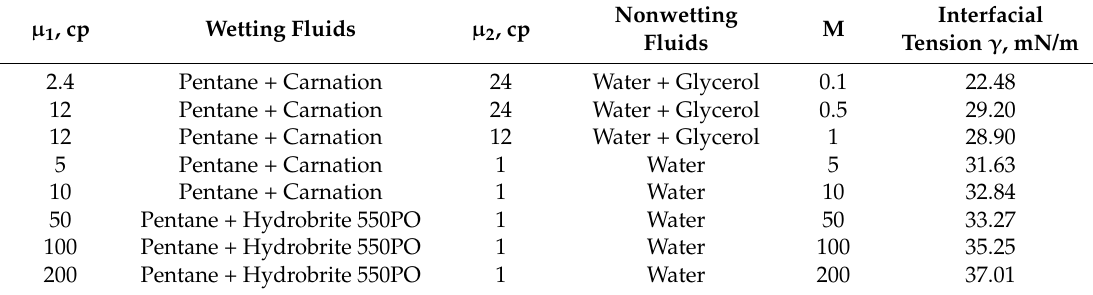
Table 2. Imbibition experiments